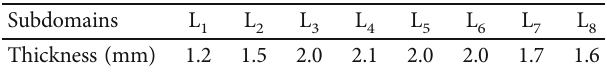
Table 4: Thickness distribution of the TRB concept tube without transition